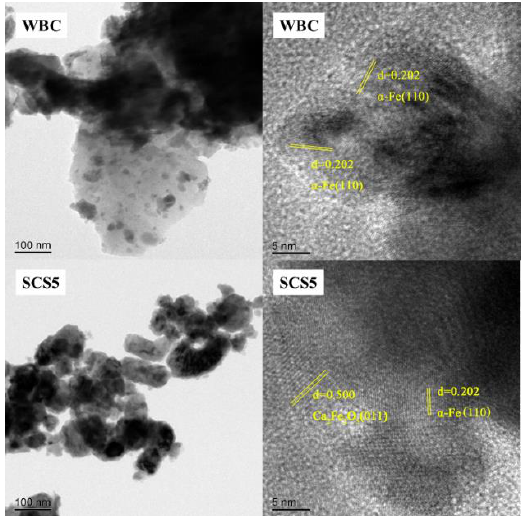
Figure 5. HR-TEM images of reduced SCS5 and WBC catalysts.